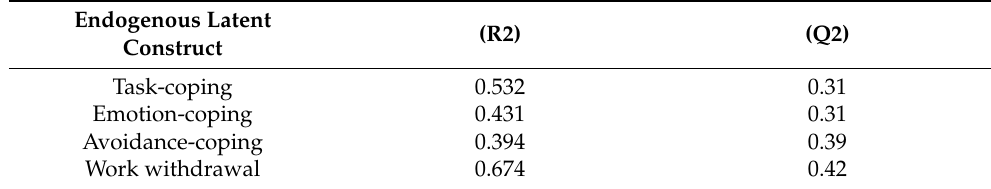
Table 5. Coefficient of determination (R2) and (Q2) of the model.